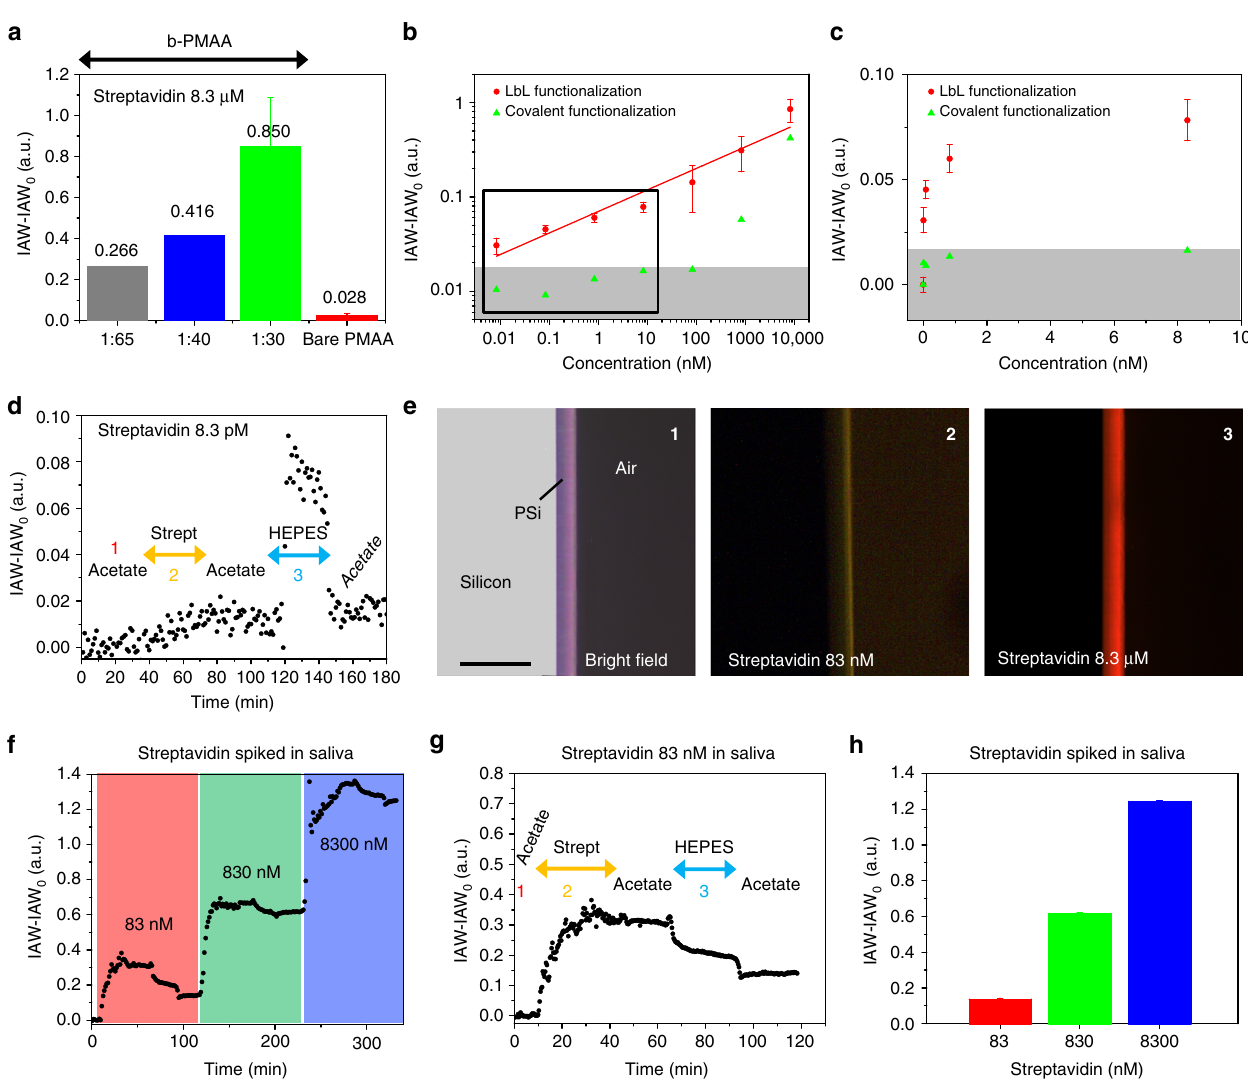
Fig. 4 High-sensitivity biosensing with LbL-biofunctionalized PSi interferometers. a IAW-IAW 0 values recorded on LbL-biofunctionalized PSi interferometers upon af fi nity interaction with 8.3 µ M streptavidin with b-PMAA at different biotinylation degrees, namely 1:65, 1:40, and 1:30. The IAW- IAW 0 value recorded on PSi interferometers LbL-coated with bare PAH/PMAA (non-biotinylated) due to unspeci fi c adsorption of 8.3 µ M streptavidin is also reported. b Calibration curve (IAW-IAW 0 vs. streptavidin concentration, log-log scale) of LbL-biofunctionalized PSi interferometers coated with b- PMAA (1:30) (red dots) for streptavidin concentration in the range 8.3 pM − 8.3 µ M; data are best- fi tted with a power law (red solid trace). The calibration curve of PSi interferometers biofunctionalized using silane-based chemistry is also reported (green triangles). The gray region represents the 3.3 σ IAW0 noise level recorded in acetate buffer. c Magni fi cation of the calibration curves in b for streptavidin concentration in the region 0 – 10 nM (linear scale). Data in a - c are provided as average values over three replicates with error bars representing one standard deviation. d Sensorgram (IAW-IAW 0 vs. time) acquired on LbL-biofunctionalized PSi interferometers coated with b-PMAA (1:30), showing speci fi c detection of streptavidin 8.3 pM (i.e., the lowest tested concentration): signal stabilization in acetate buffer (step 1); injection of streptavidin and af fi nity interaction of streptavidin with b-PMAA (step 2); repulsive rinsing in HEPES buffer and removal of streptavidin unspeci fi cally adsorbed on b-PMAA (step 3). e Bright- fi eld (1) and fl uorescence (2, 3) images of the cross-section of the oxidized PSi interferometer LbL-coated with PAH/b-PMAA after af fi nity binding of 83 nM (2) and 8.3 µ M (3) sulfo-rhodamine- labeled streptavidin (scale bar is 15 µ m). f Sensorgrams (IAW-IAW 0 vs. time), acquired on LbL-biofunctionalized PSi interferometers coated with b-PMAA upon consecutive injections of diluted saliva spiked with 83, 830, and 8300 nM of streptavidin. g Sensorgram (IAW-IAW 0 vs. time) of the injection of diluted saliva spiked with streptavidin 83 nM, highlighting the different injection steps. h Bar graph of IAW-IAW 0 signals acquired after injection of diluted saliva spiked with streptavidin 83, 830, and 8300 nM. Data are provided as average values of IAW-IAW 0 fl uctuations over time (data points = 30) with error bars representing one standard